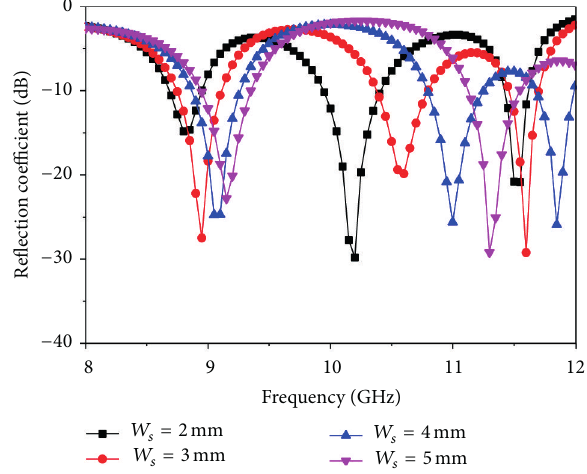
Figure 4: Simulated reflection coefficient for different values of 𝑊 𝑠 (other parameters: 𝐿 = 20 mm, 𝑊 = 17.2 mm, 𝐿1 = 3 mm, 𝐿2 = = 9 mm, 𝐿 = 20 mm, 𝑊 = 17.2 mm, 𝑅1 = 2 mm, 13 mm, 𝐿 𝑠 𝑔 𝑔 𝑌 = 10, 8.6 𝑅2 = 3 mm, 𝑋 𝑓 , 𝑓